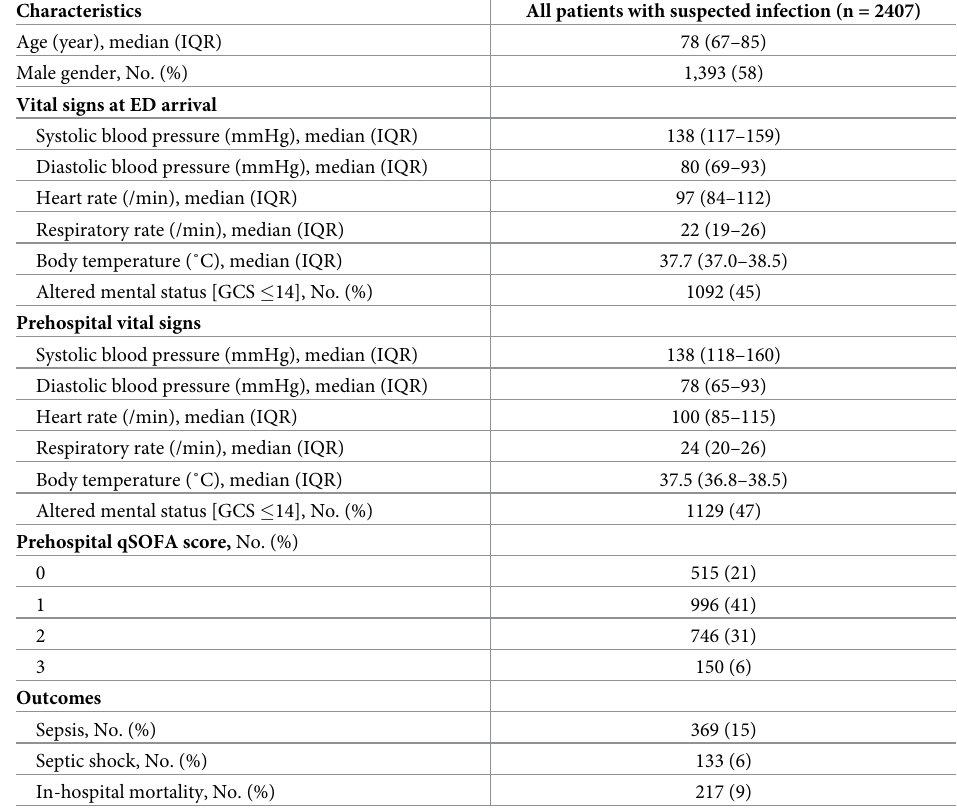
Table 2. Characteristics of 2,407 patients with suspected